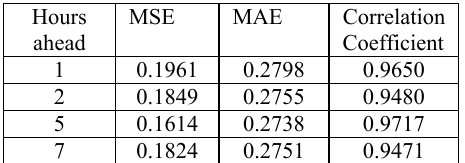
Table 2. Errors and correlation coefficients in Case 2 for all